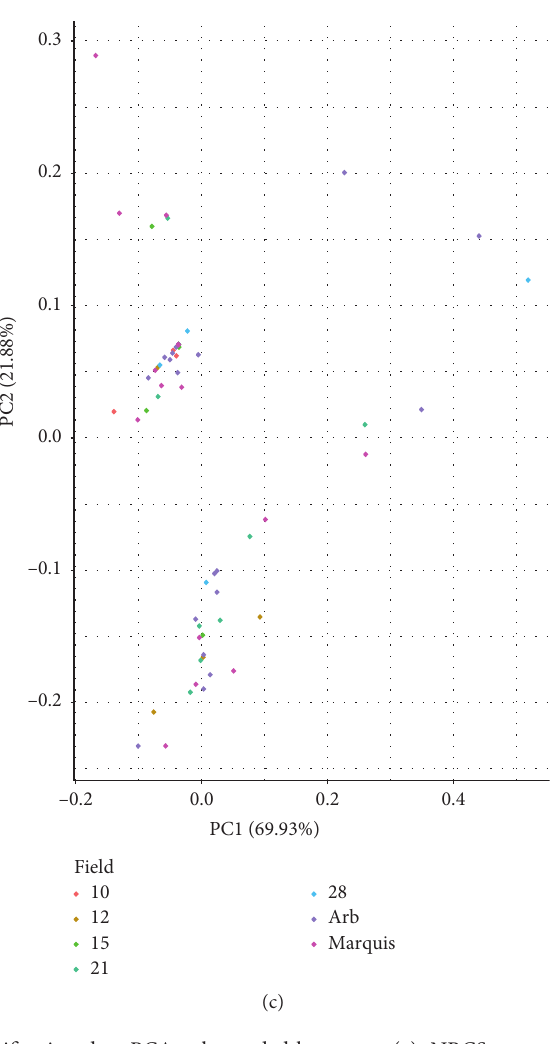
Figure 5: Soil classification data PCA color-coded by season (a), NRCS texture (b), and field (c).